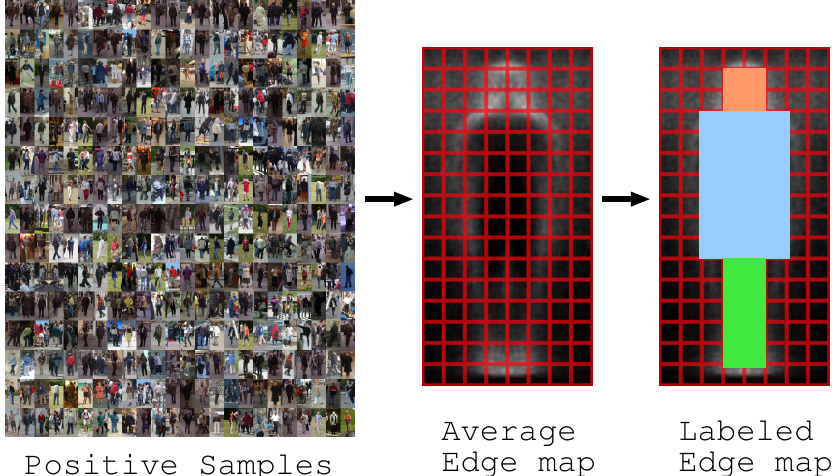
Figure 10. Generate edge map.